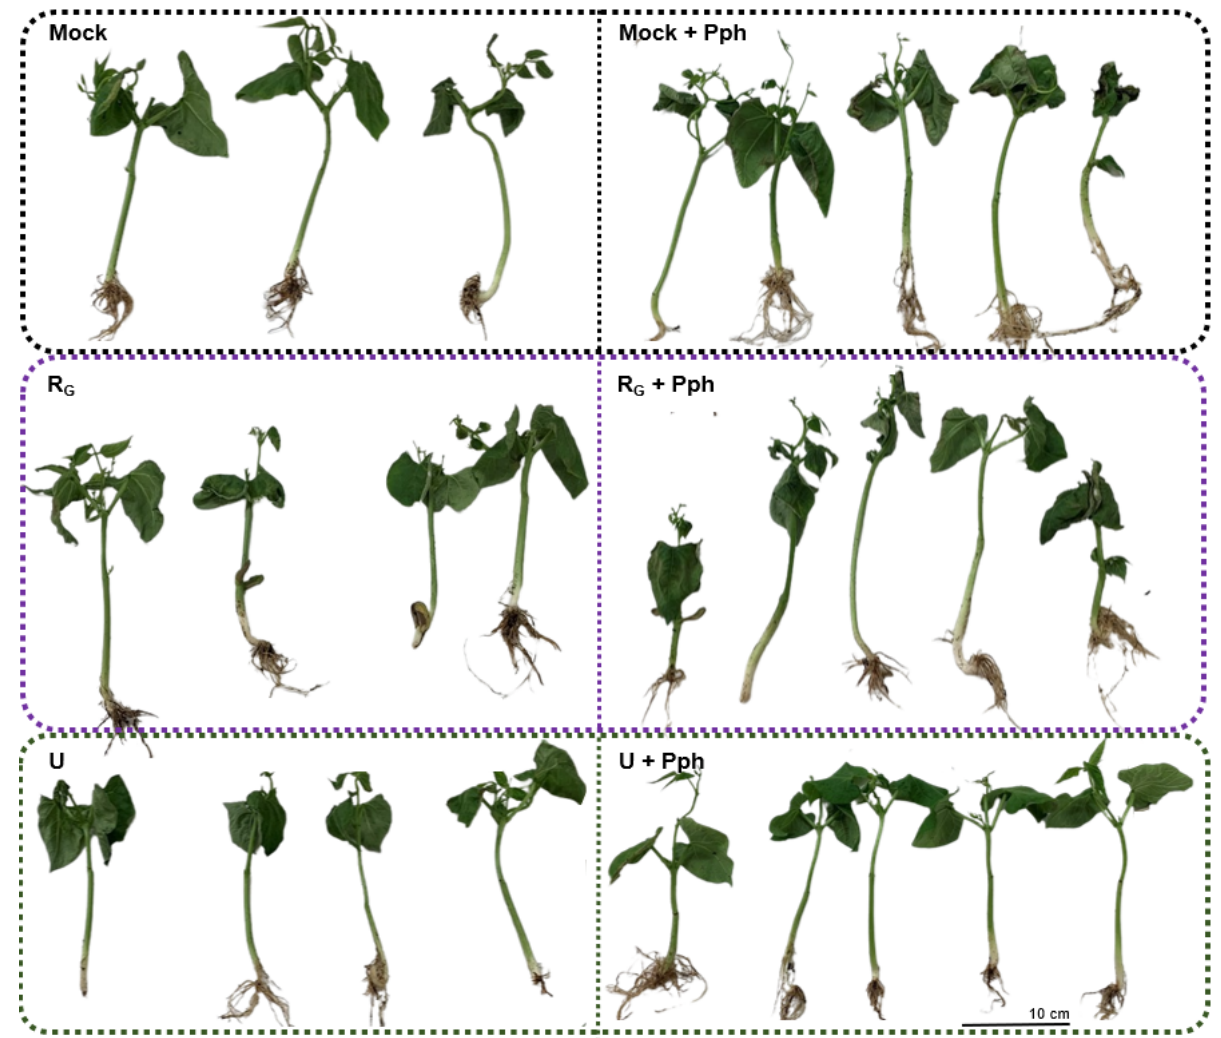
Figure 6. Phenotypic damage caused by the virulent P. syringae pv. phaseolicola (Pph) in common bean plants. Entire plants are shown to compare symptoms in Mock; after the Pph inoculation (Mock + Pph); in plants pre-treated with grapevine pomace (R G -PBP), with (R G + Pph) or without (R G ) Pph inoculation; and plants pre-treated with Urtica dioica (U-PBP), with (U + Pph) or without (U) Pph inoculation. Pictures correspond to one experiment representative of three independent ones with similar results.